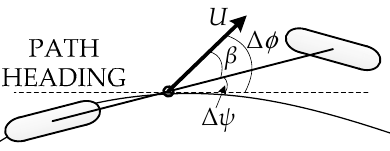
Figure 5. The relationship between the course-direction deviation Δ φ , sideslip β and the heading deviation Δ ψ .